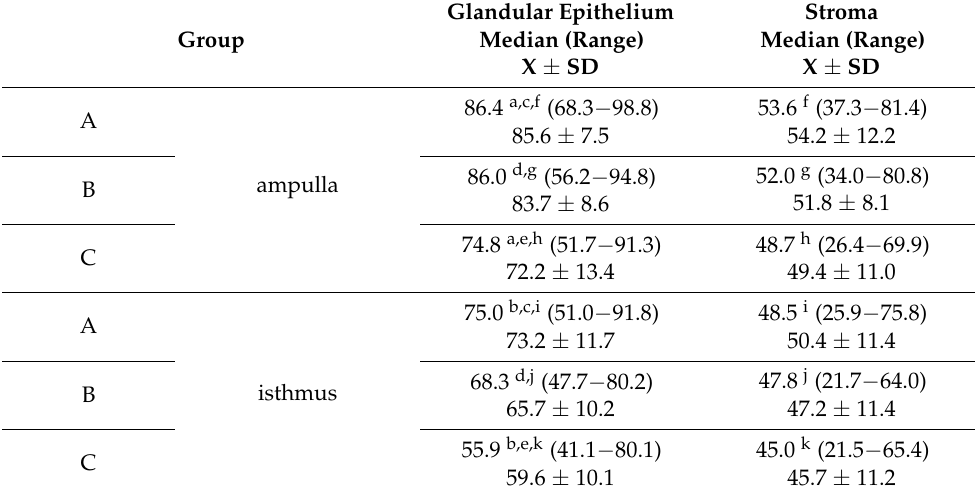
Table 3. The percentage of PR-positive cells in the glandular epithelium and the stroma of